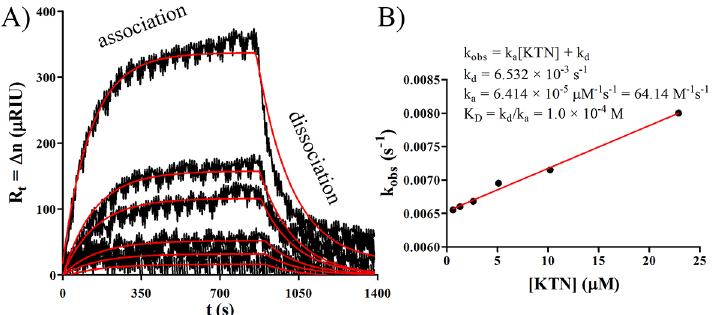
and fitted with Langmuir curves (red trace). B) Linear regression plot of kobs vs [KTN] was used to obtain the slope = ka, y-intercept = kd, and KD = kd/ka.